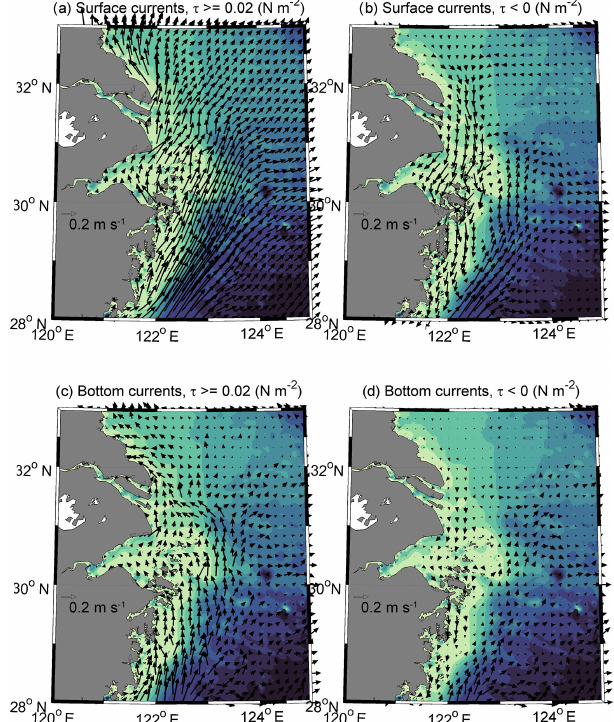
Figure 12. Maps of surface (a, b) and near-bottom (c, d) cur- rents in the sea bottom depths down to 100m in the cases of wind stress component τ c ≥ 0 . 02Nm − 2 (a, c) and τ c < 0Nm − 2 (b, d) in 1993–2018. Every fourth current vector is shown.